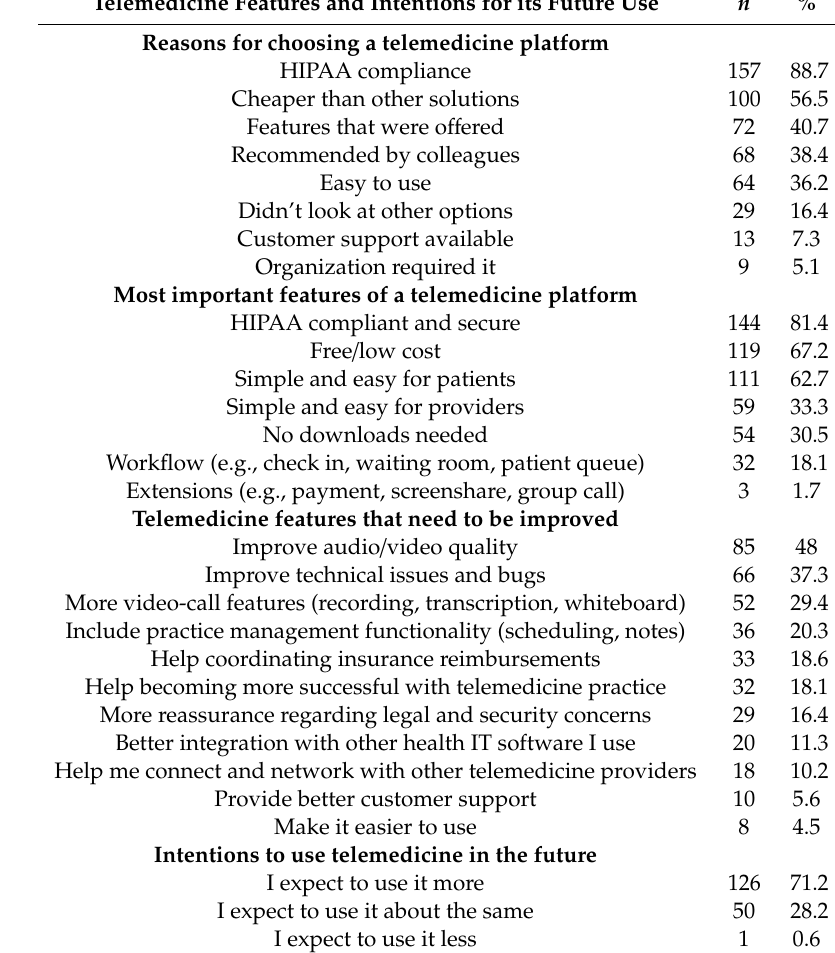
Table 4. Reasons for telemedicine use, important features, and intentions for its future use, N =